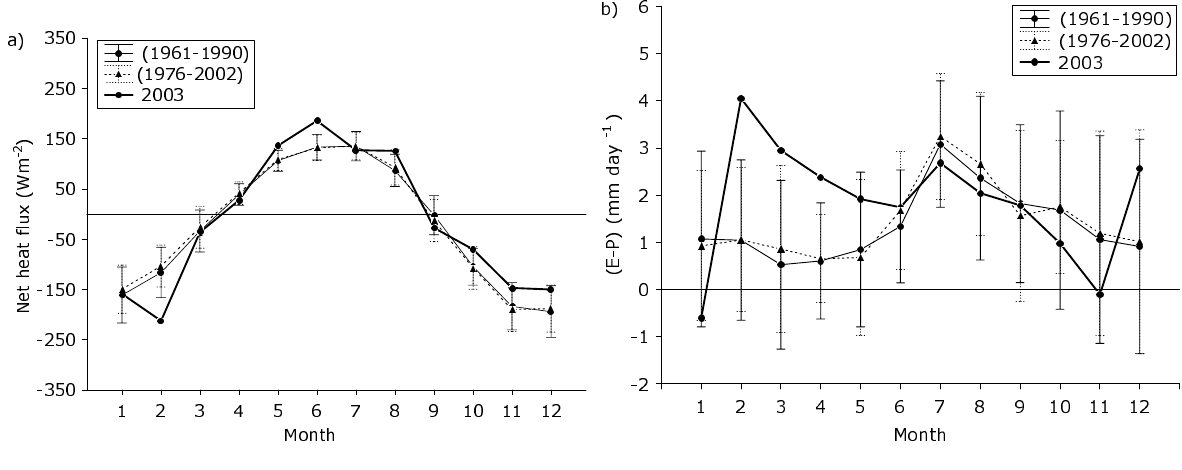
Fig. 4. Monthly mean (a) net heat and (b) water flux (evaporation – precipitation) computed at Split-Marjan for the periods 1961–1990 and 1976–2002 and for the year 2003. Vertical bars represent interannual standard deviations for particular